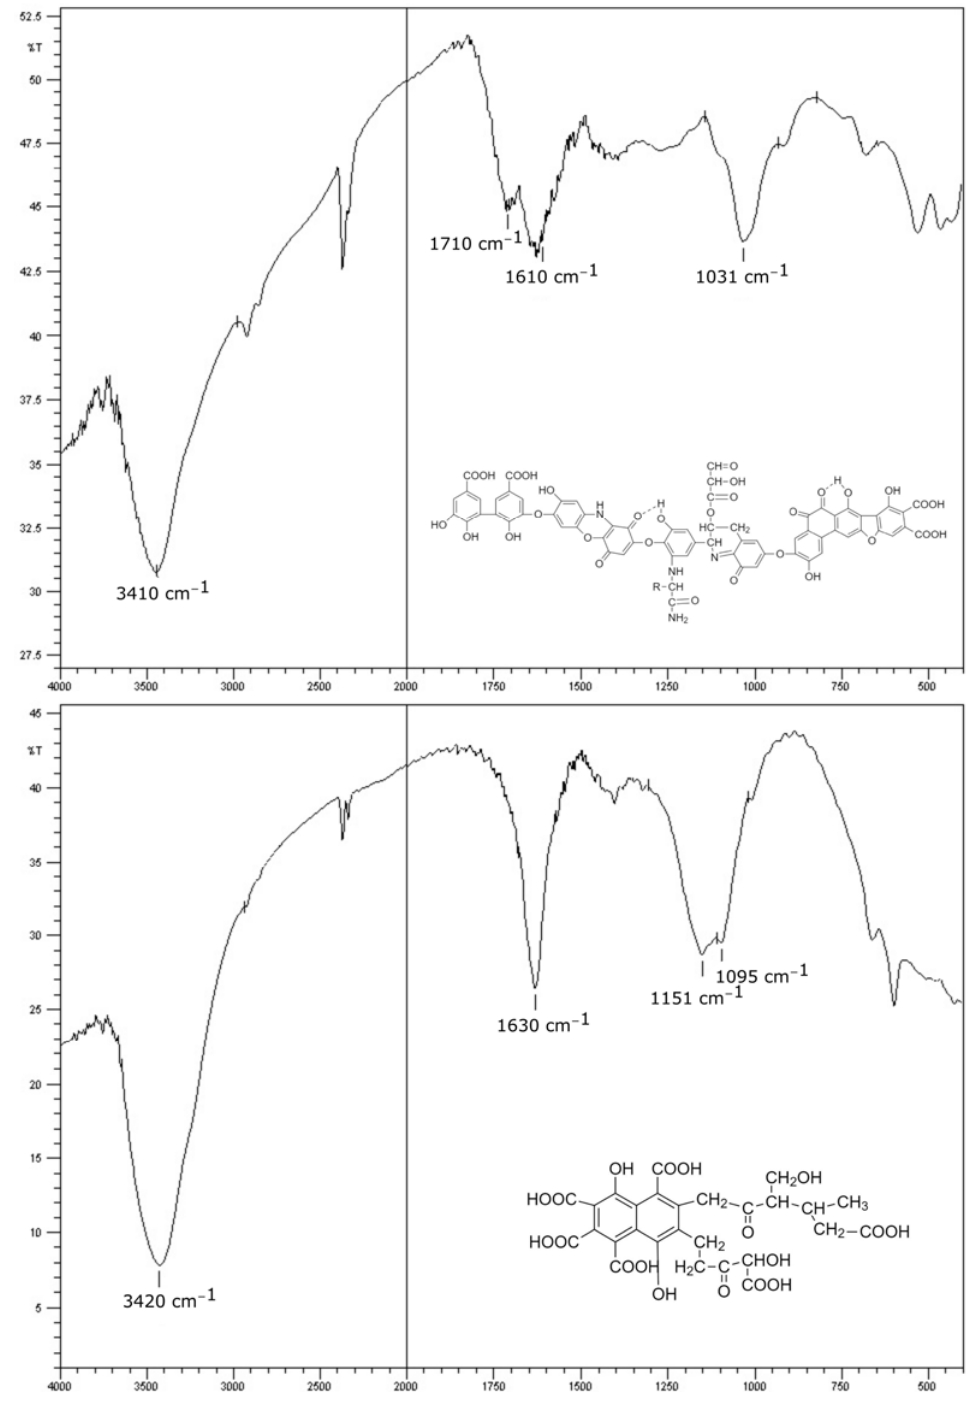
Figure 2. FT-IR spectra of HA ( upper spectrum ) and FA ( lower spectrum ) along with the hypothet- ical model structures proposed by Wang et al. [23].